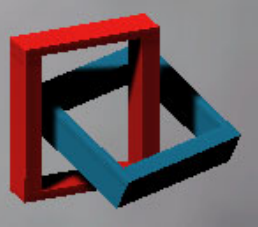
Fig. 15. Intertwining of two ring-like